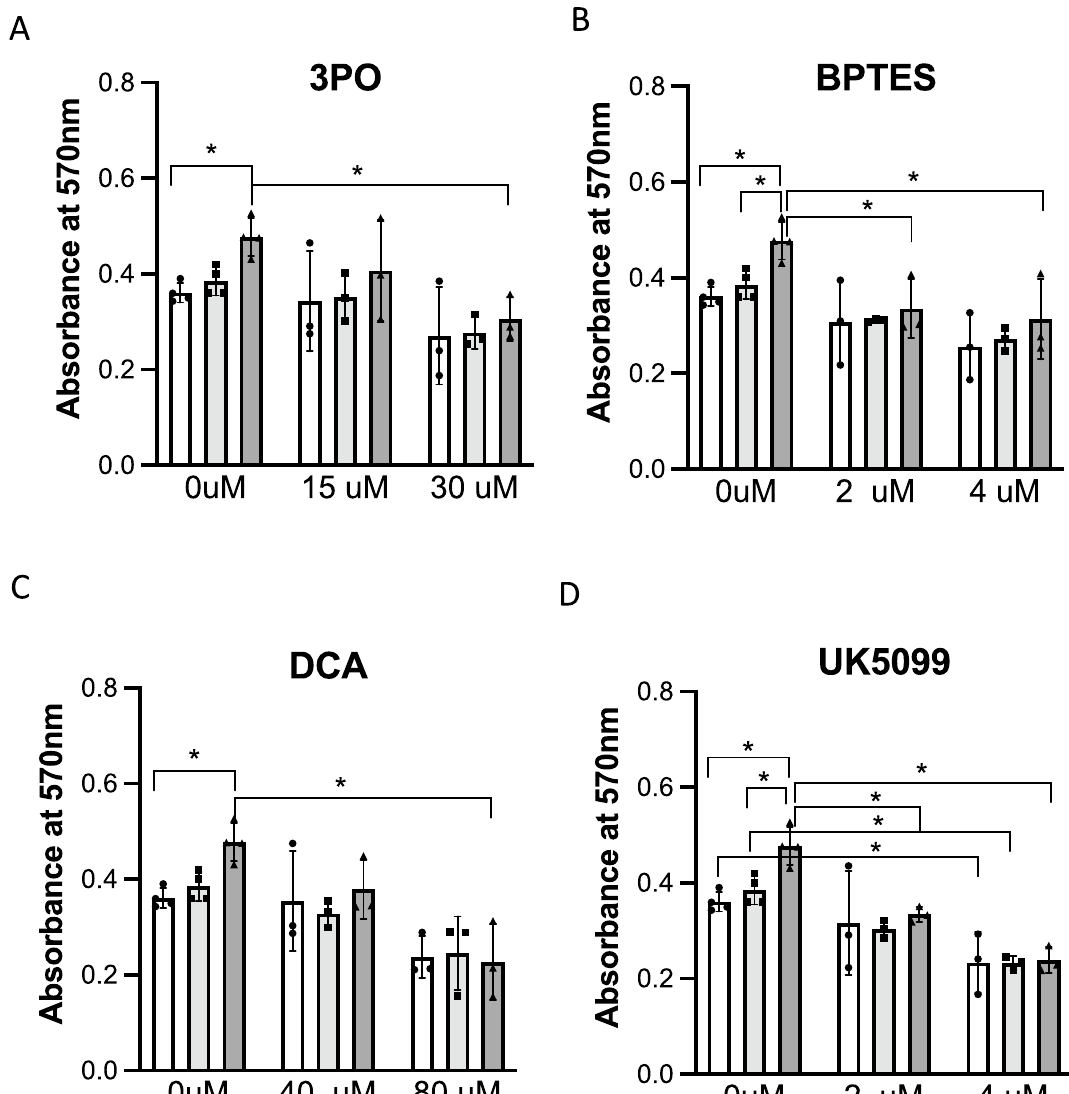
Figure 5. Cellular basal viability and upon metabolic inhibition. Cellular basal viability and the effect of metabolic inhibition was evaluated by use of MTT. 3PO (glycolytic inhibitor), BPTES (glutaminase inhibitor), UK5099 (mitochondrial pyruvate carrier blocker) and DCA (PDK1 inhibitor) showed a dose dependent effect on the viability of all three groups studied. CTEPH-EC, n = 3; PAH-EC, n = 3; HPAEC, n = 4; Two-way ANOVA followed by Tukey´s multiple comparison test was used. Data is expressed as mean ± SD, p < 0.05 = *. Statistical analysis was performed with GraphPad Prism 7 software, version 7.0e, serial number:GP7-0,633,739-R###- #####,https:// www. graph pad.